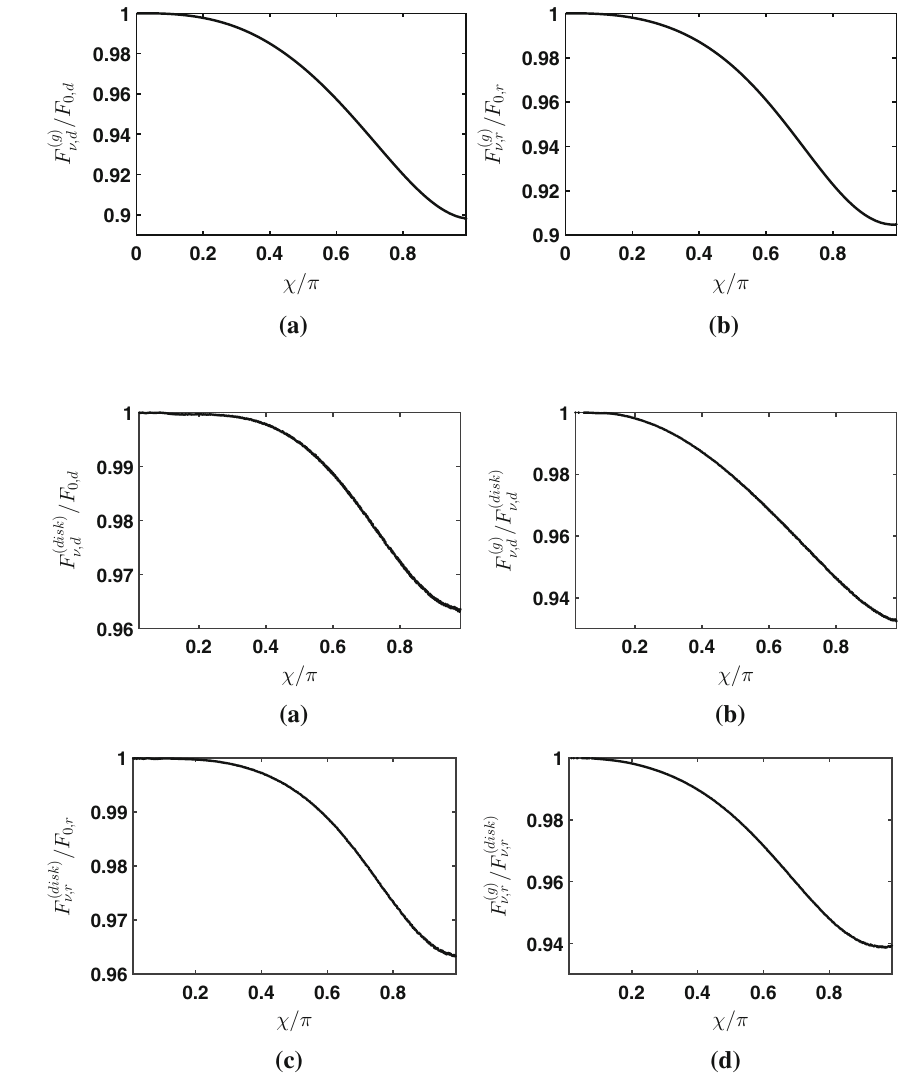
Fig. 5 The ratios of fluxes of ultrarelativistic neutrinos, based on Eqs. (19) and (22), and scalar particles in their scattering off a Kerr BH versus χ/π . a Direct scattering; b retrograde scattering. Particles are ultrarelativistic, having E (cid:6) m . BH is maximally rotating with a = M